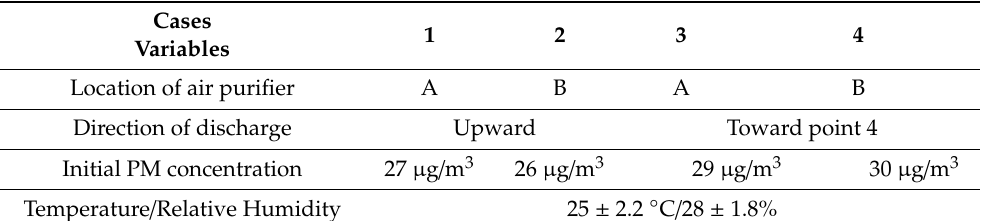
Table 2. Experiment case